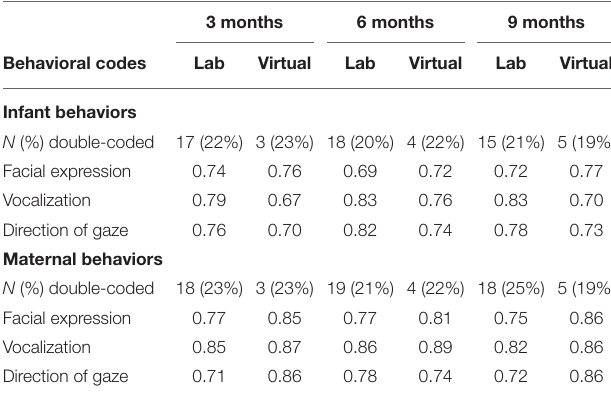
TABLE 2 | Interobserver reliability statistics (Cohen’s kappa) for infant and maternal behaviors in the Still Face Paradigm separately by visit